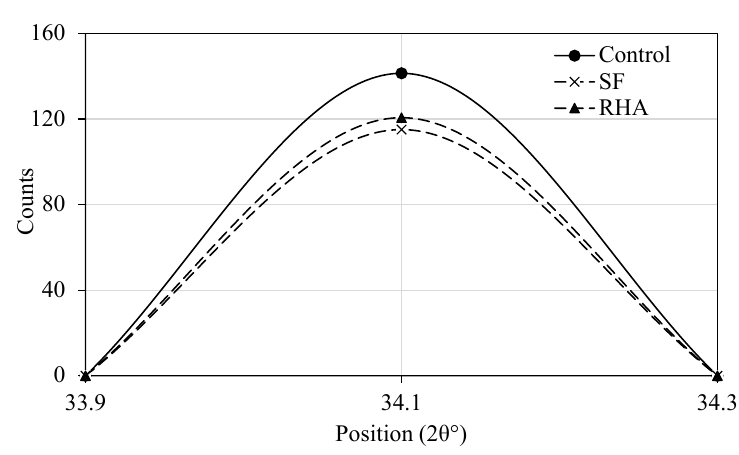
Figure 7. Peak of